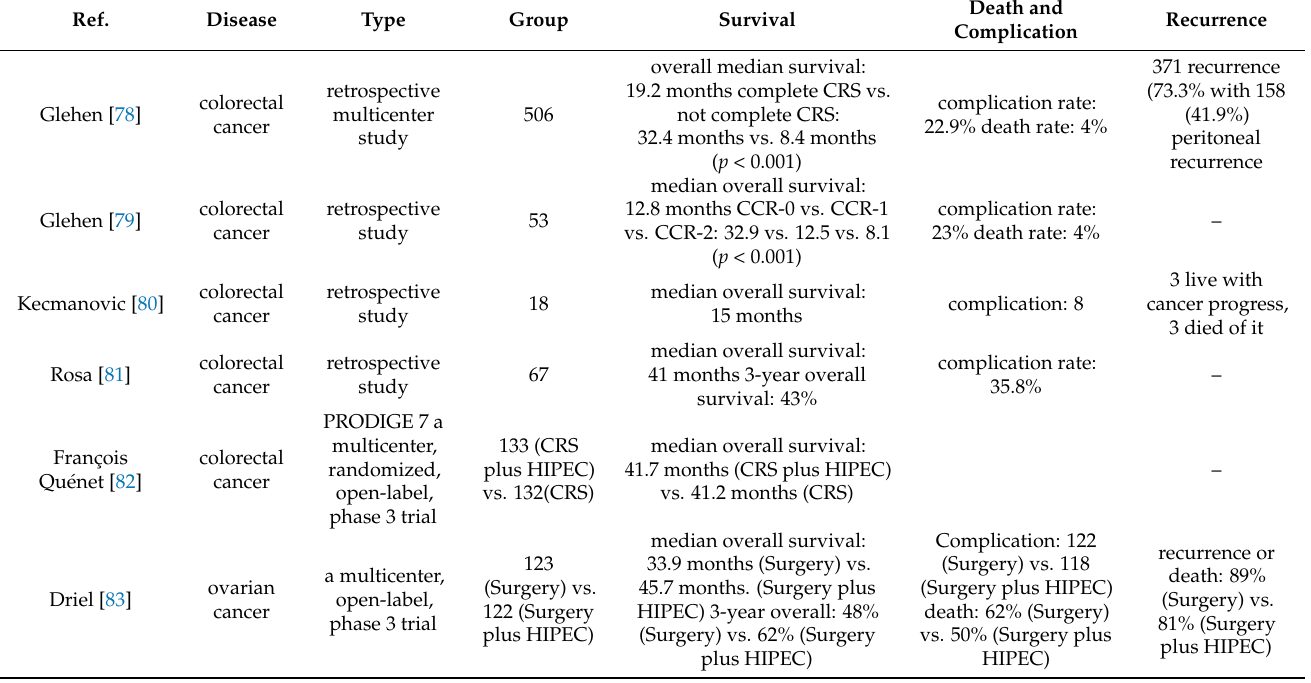
Table 1. Different studies of HIPEC in different